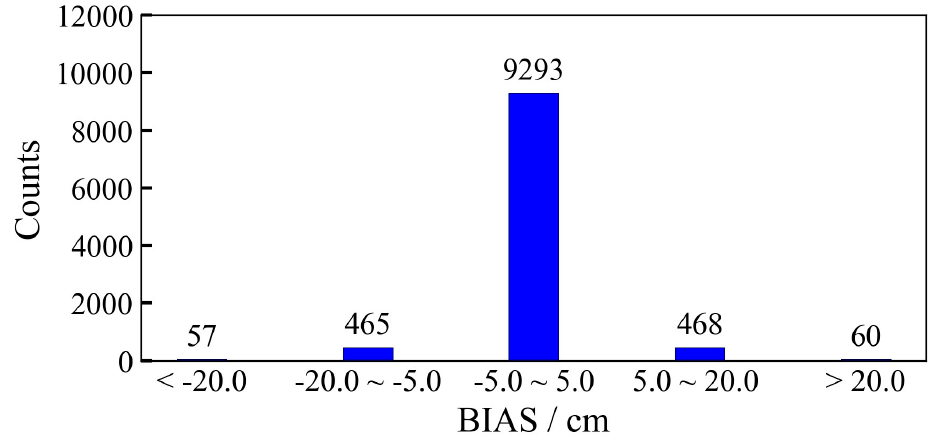
Figure 4. Density scatterplots of the fused snow depth and in situ observations between 2002 and 2011.